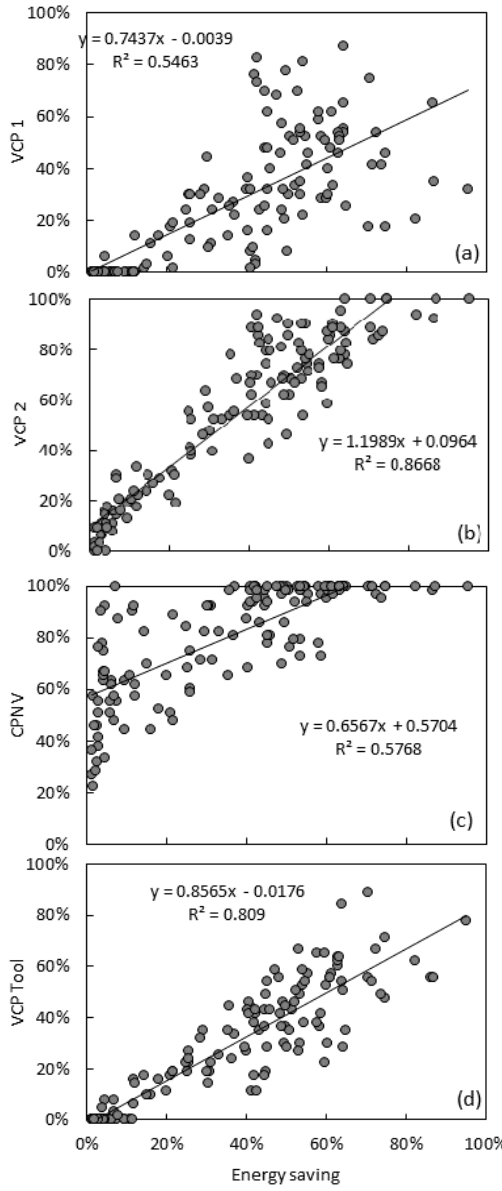
Figure 8. Correlations between VCPs and energy savings: ( a ) VCP 1 , ( b ) VCP 2 , ( c ) climatic potential for natural ventilation (CPNV), and ( d ) VCP tool.